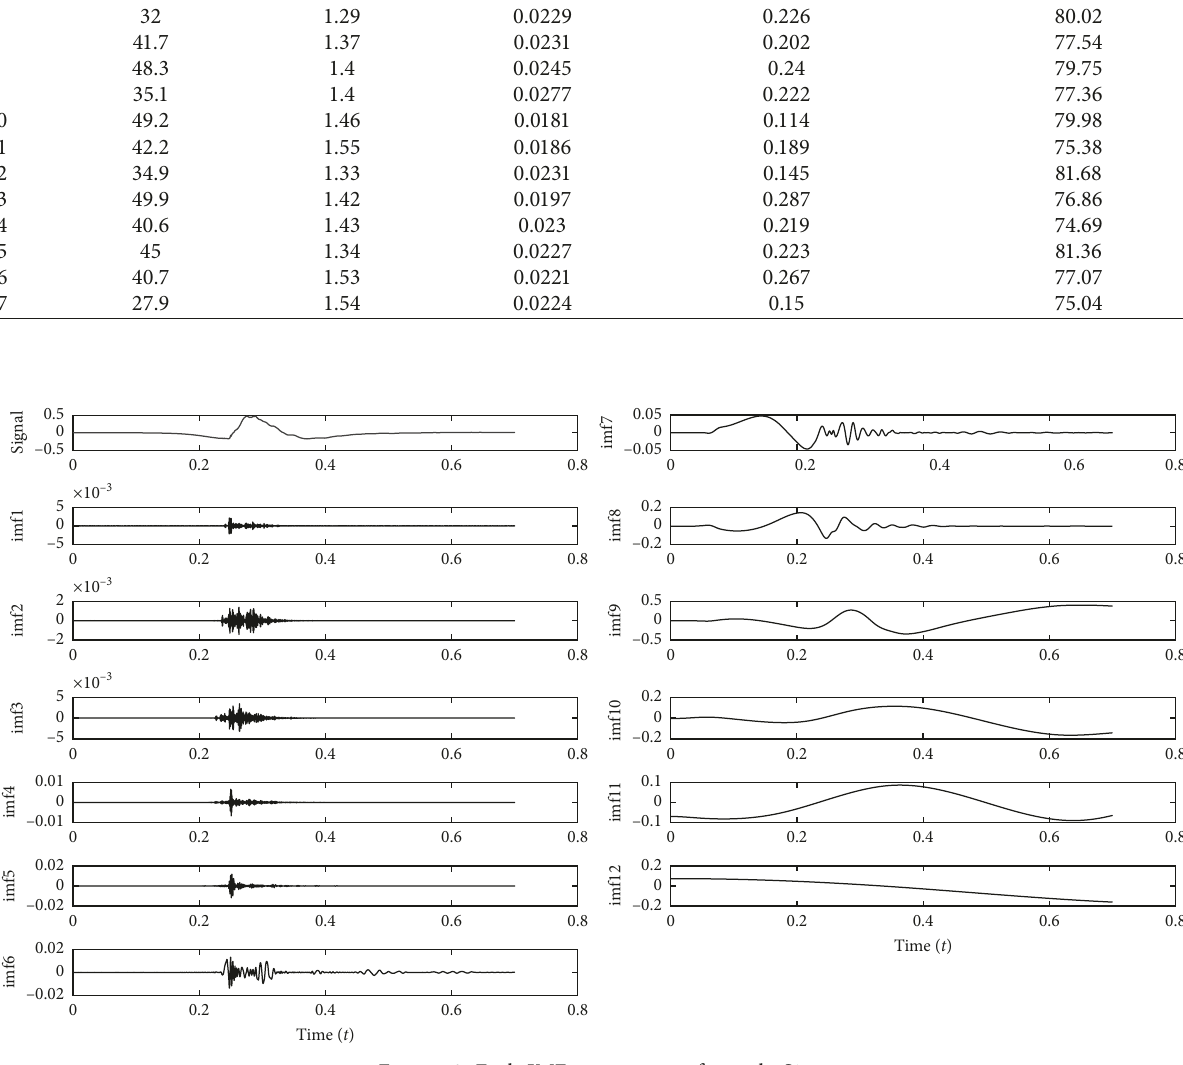
Figure 2: Each IMF component of sample S